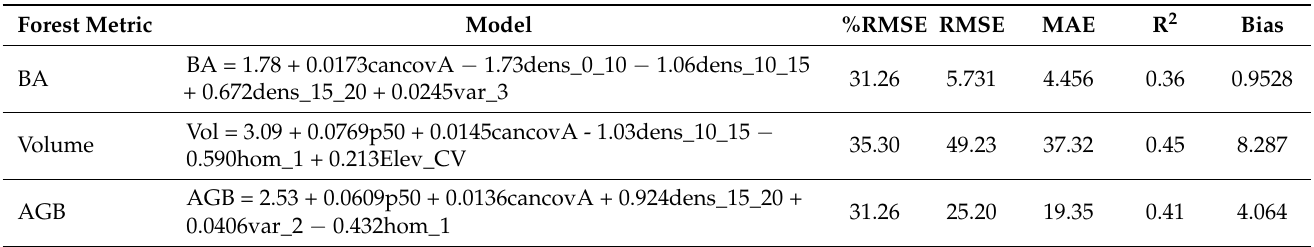
Table 5. Models predicting BA, Volume, and AGB.